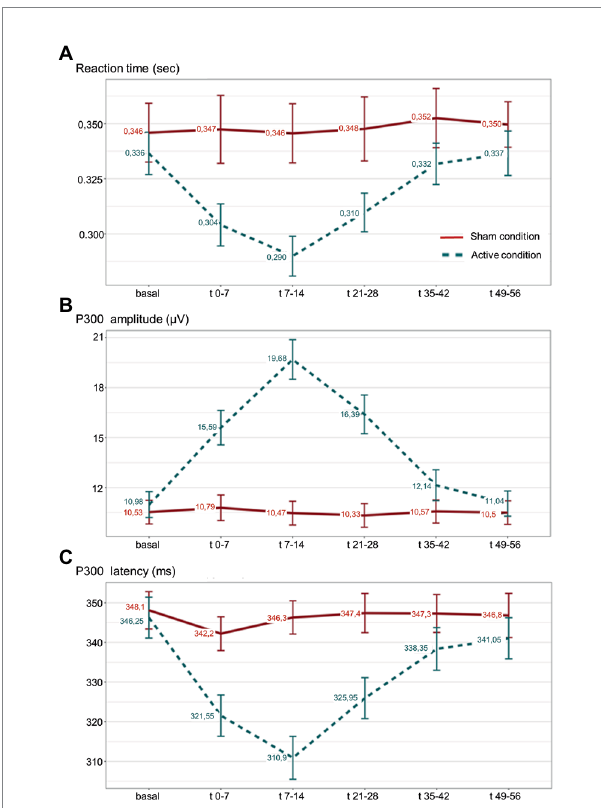
FIGURE 4 (A) Reaction time (RT); (B) amplitude; and (C) P300 latency, mean values along successive P300 blocks during active taVNS (dashed line) and sham (continuous line) conditions are represented, with their respective standard error of the mean. Sec: seconds; μ V: microvolts; ms: